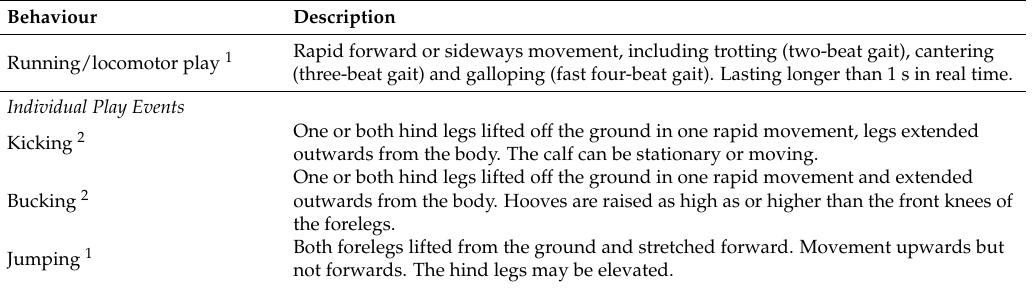
Table 1. Description of